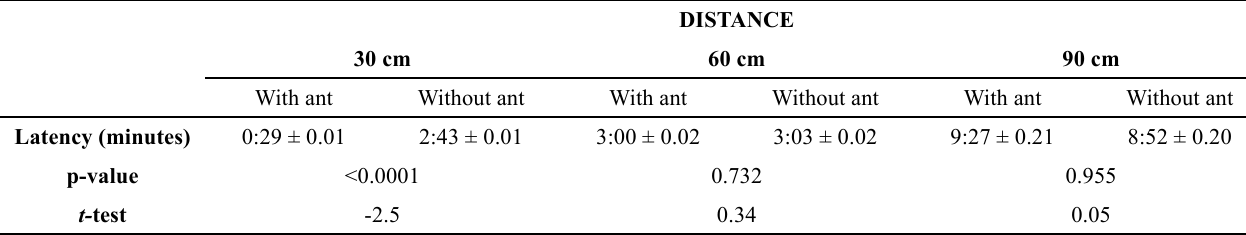
Table 2. Average latency times of rescue ants present in the capture chamber positioned at different distances.